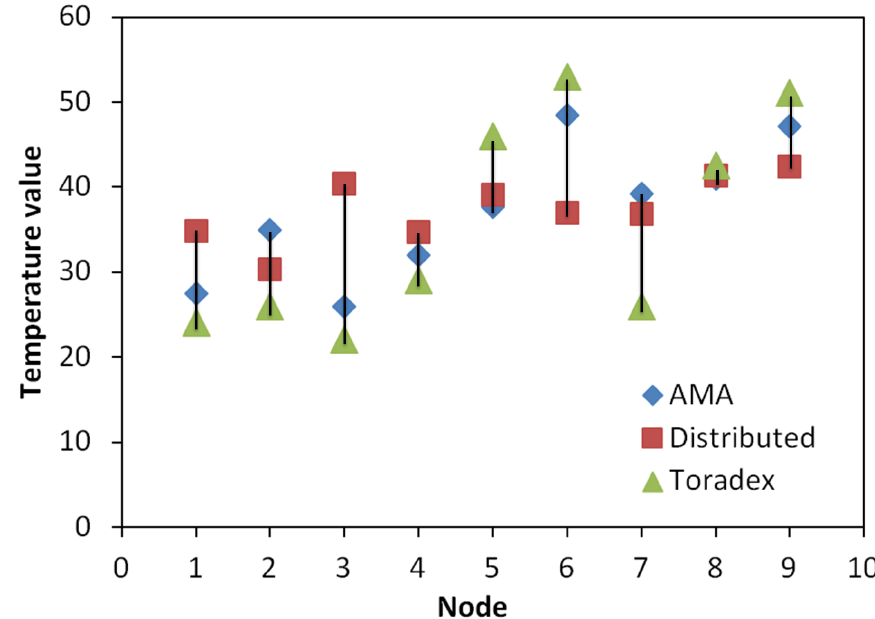
Figure 18. The temperature values calculated by the distributed mapping service and by AMA compared to the actual